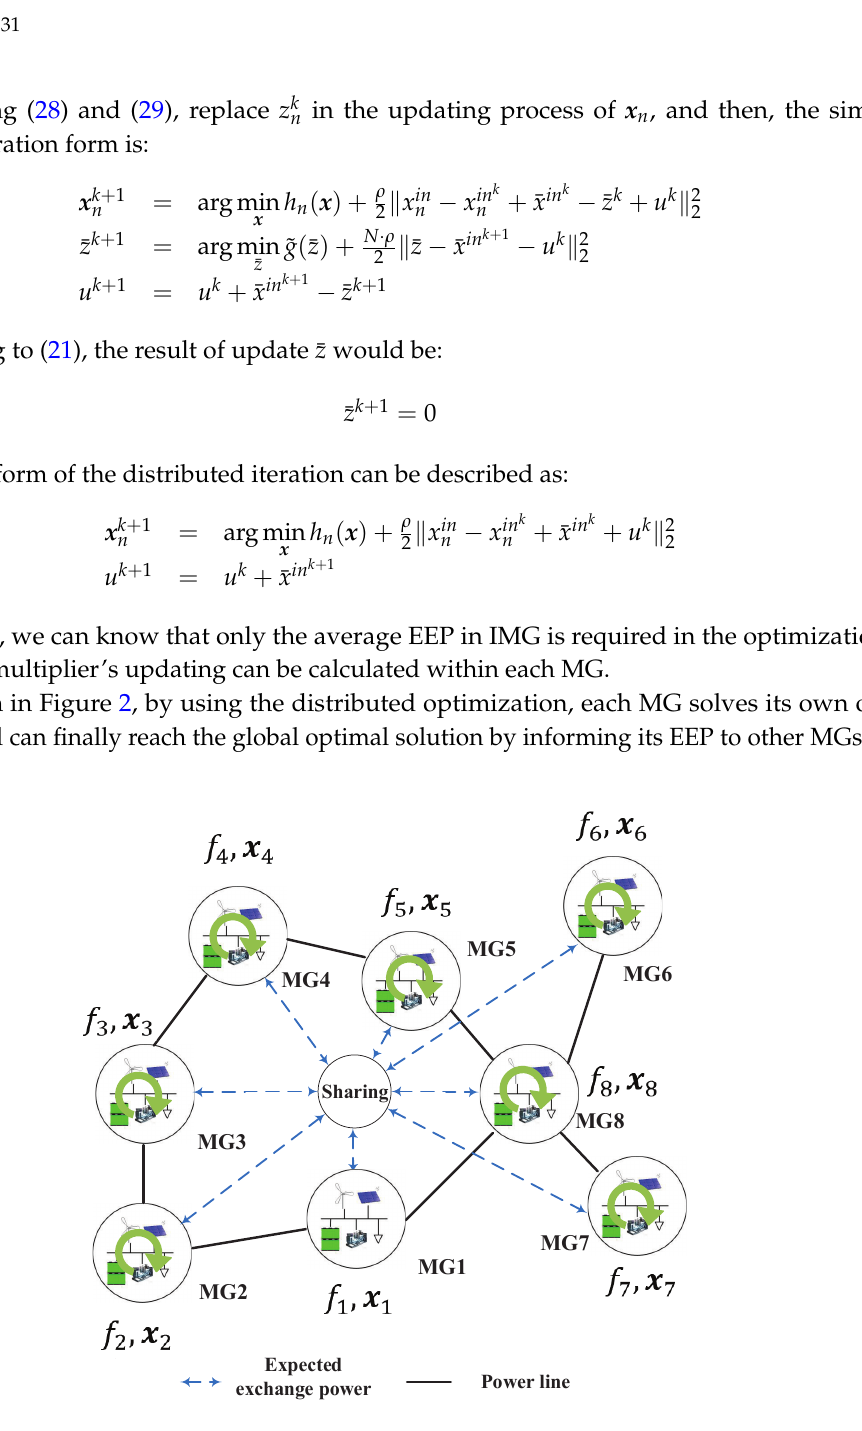
Figure 2. Distributed optimal scheduling of the